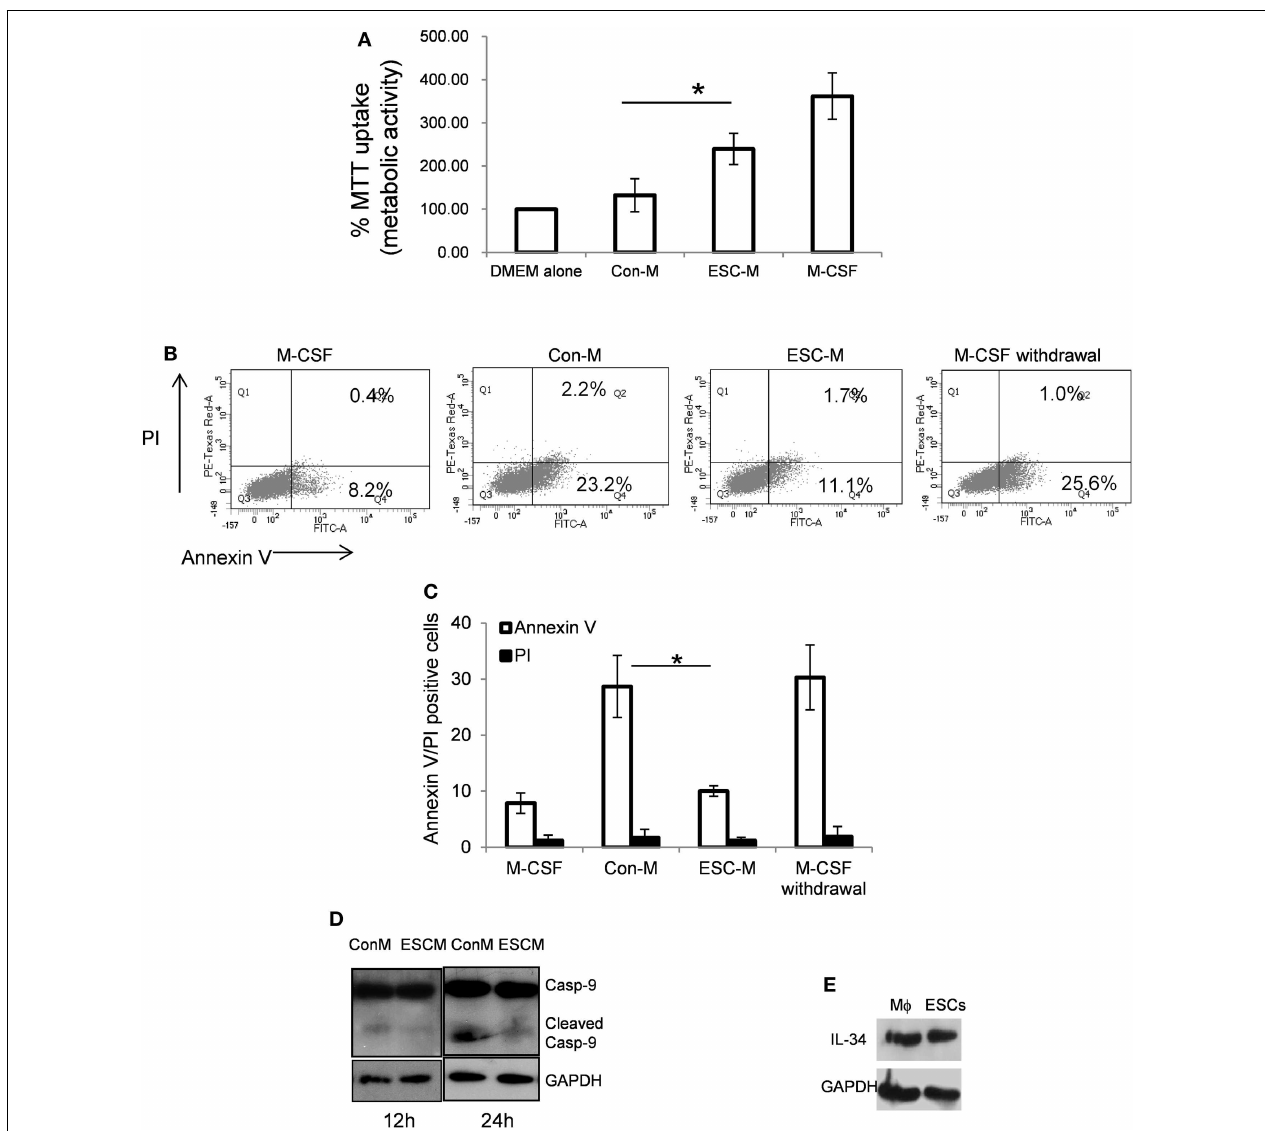
ESC-M, Con-M, DMEM with M-CSF, and DMEM alone for 24h, respectively ( n = 3). (D) Effect of ESCs on caspase-9 activation. BMDMs were treated with Con-M and ESC-M for 12 and 24h, respectively and whole cell lysates were analyzed byWestern blotting for caspase-9 activation. (E) IL-34 in BMDMs and ESCs was detected byWestern blot analysis. * p < 0.05, two-sidedWilcoxon test. Data are represented as mean ±